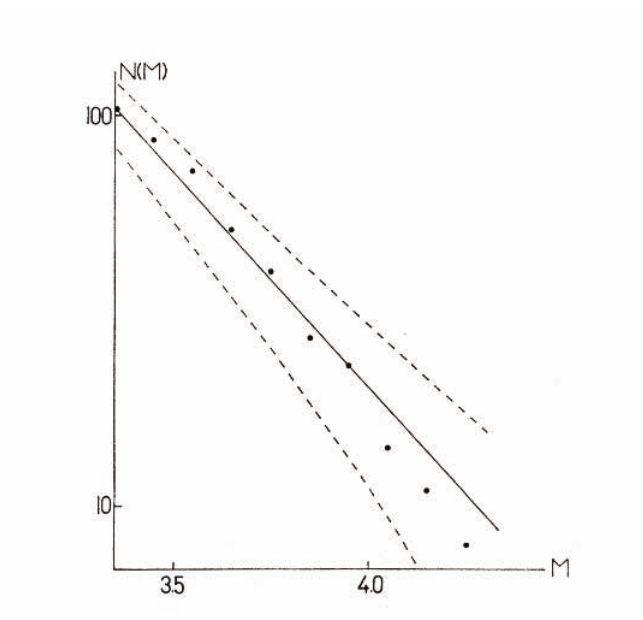
Figure 11. Magnitude-frequency distribution: Cremasta